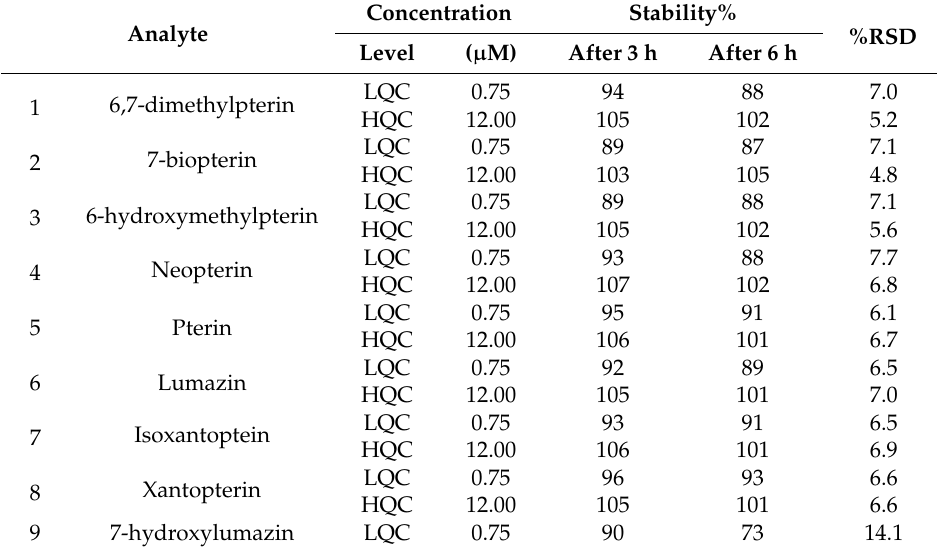
Table 3. Samples’ stability in the autosampler.